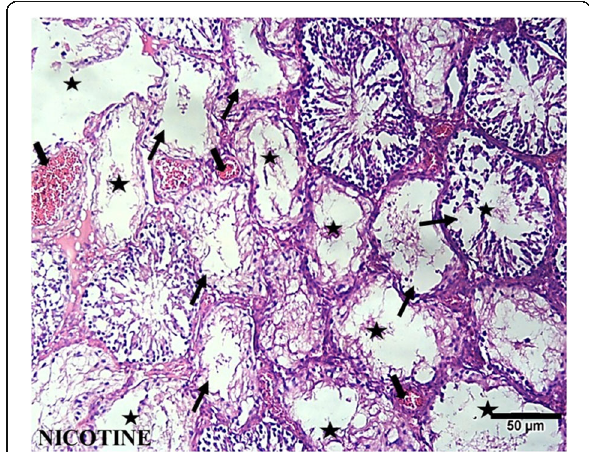
Fig. 14 Representative micrograph from the Normal Control group. Observe the oval shaped tubules with thin basement membrane containing seminiferous epithelium in which are embedded an orderly array of spermatogenic cells (Sp). The luminal (L) is replete with spermatozoa. Stain: H&E; Scalebar: